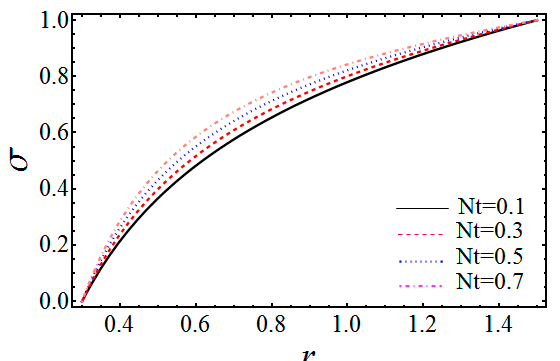
Figure 12. Variation of temperature profile σ with Nt for fixed θ = 0.1, ϕ = 0.5, δ = 0.2, ε = 0.1, z = 0, t = 0.2, Nb = 0.2.